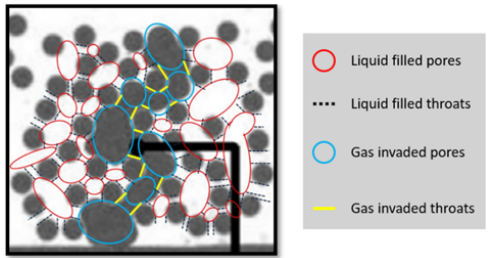
Figure 7. Microfluidic drainage experiment from Arbabi et al. [20] (Reprinted with the permission from Elsevier, 2014). Solids and gas invaded area in black, liquid in white. The PN is identified by the circles and throats. The image shows the steady-state invasion pattern after breakthrough of the gas phase from inlet ( at the bottom ) to water channel ( at the top